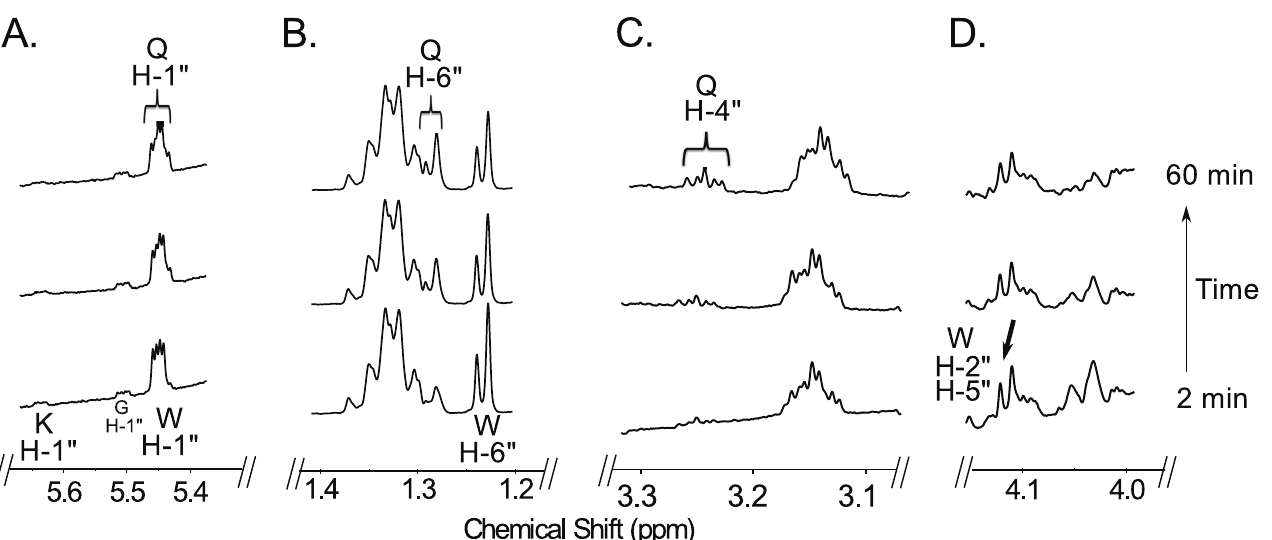
Fig 9. Time-resolved 1 H-NMR analysis of Preq reaction showing the conversion of hydrated-UDP-4-keto-6-deoxy-GlcNAc to UDP-QuiNAc. Spectra were collected for the first 60 min of the reaction that was conducted at 25°C and included Preq and 1 mM NADPH after Pdeg reaction. Four selected regions of the UDP-QuiNAc formed over time, can be observed with a diagnostic anomeric proton QH-1 ” (A), 6-deoxy proton QH-6 ” (B), appearance of QH-4 ” . Proton signals of UDP-QuiNAc are labeled as QH-1 ” , QH-6 ” , and QH-4 ” and disappearance of WH-2 ” and WH-5 ” (D). Note that the chemical shift of the anomeric proton of UDP-QuiNAc (QH-1 ” ) is very close to the proton of UDP-4-keto-6-deoxy-GlcNAc (slightly shifted). WH-1 ” is the hydrated form of UDP-4-keto- 6-deoxy-GlcNAC.